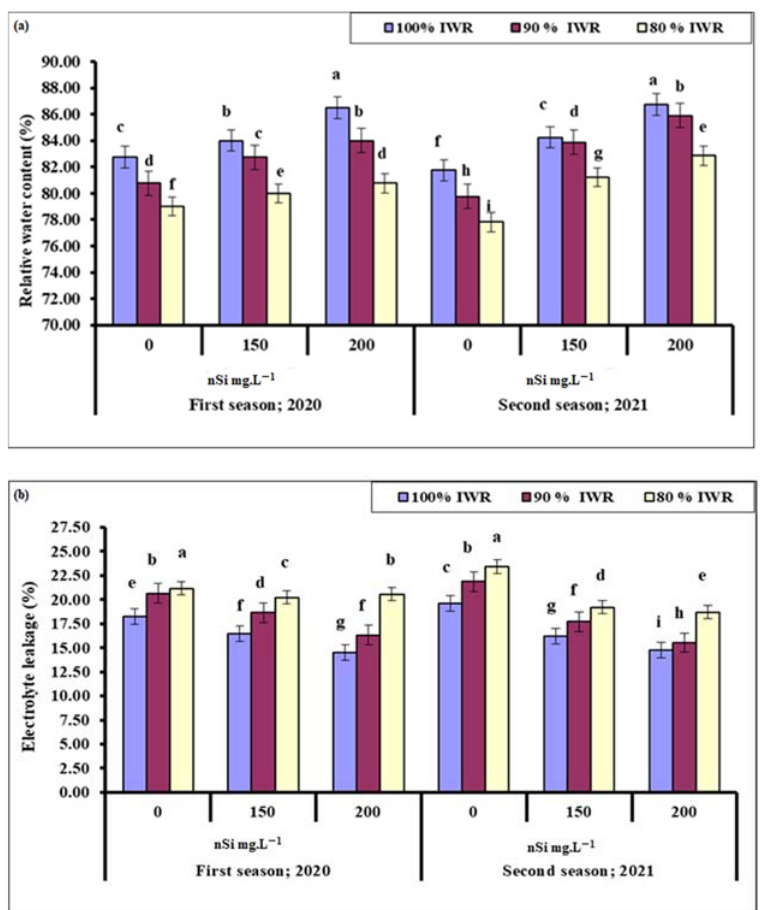
Figure 3. Effect of foliar sprayed nano-silicon (nSi) under different irrigation regimes on the leaf relative water content ‘RWC’ ( a ) and electrolyte leakage ( b ) of ‘Kalamata’ olive trees during the 2020 and 2021 seasons ( n = 10). Means with similar letters for each season are not significantly different, using Duncan’s multiple range test (DMRT) at p ≤ 0.05. Error bars represent the standard error of the means.